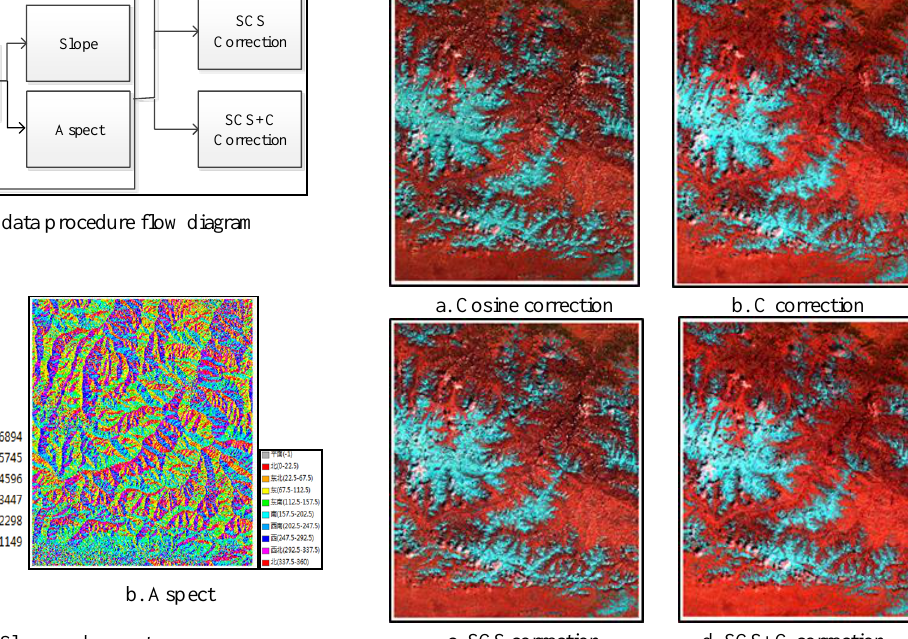
Figure 4. Comparison after correction (band 5, 4,